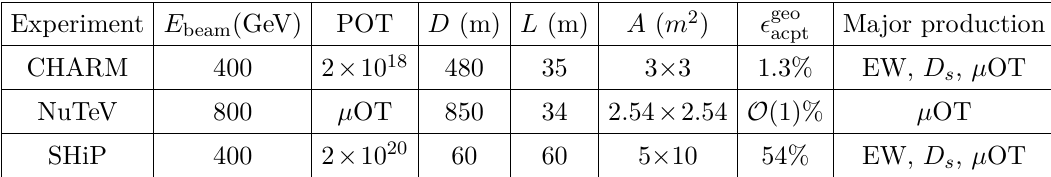
Table 1 . Major experiments and parameters for the τ − µ case, see details in the text. For compar- ison, we list the geometric acceptance for the D s production at CHARM and SHiP